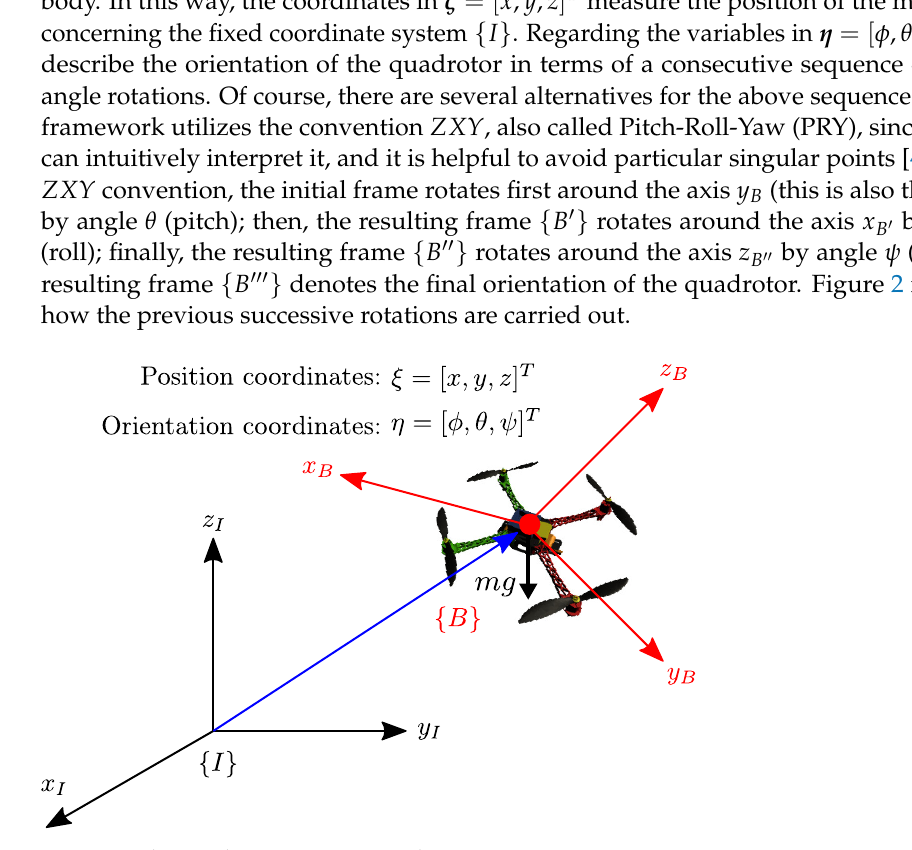
Figure 1. The quadrotor navigation scheme.